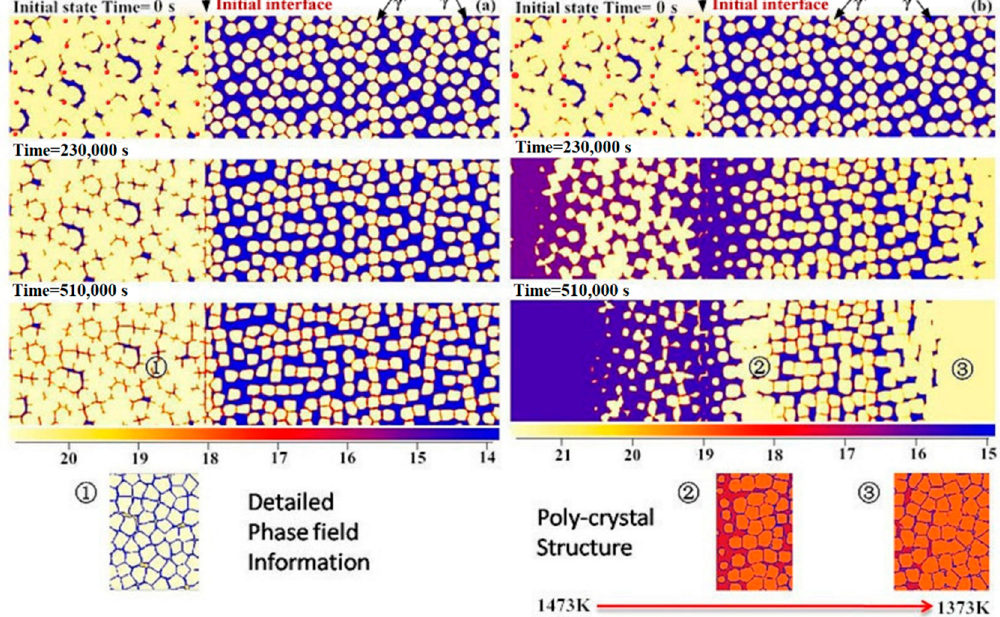
Figure 7. Phase-field simulated microstructure evolution of No. 3 γ + γ '/ γ + γ ' bond coat/substrate system (Ni–20at.%Al–8at.%Cr/Ni–18at.%Al–12at.%Cr) annealed ( a ) at 1373 K and ( b ) with an effect of temperature gradient Δ G = 5000 K/cm. The color bar scale indicates the mole fraction of Al in atom percent.